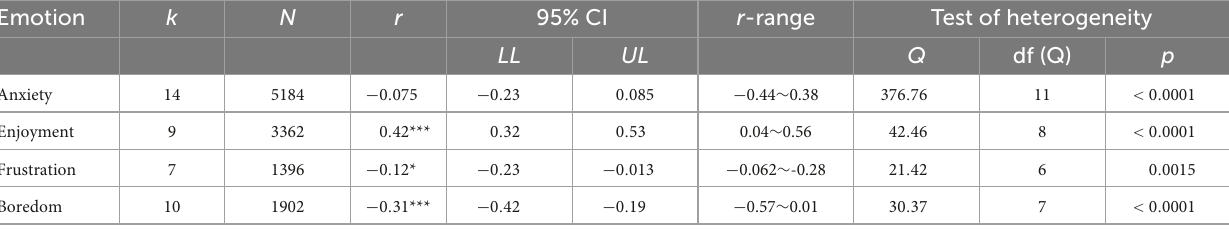
TABLE 2 Meta-analysis